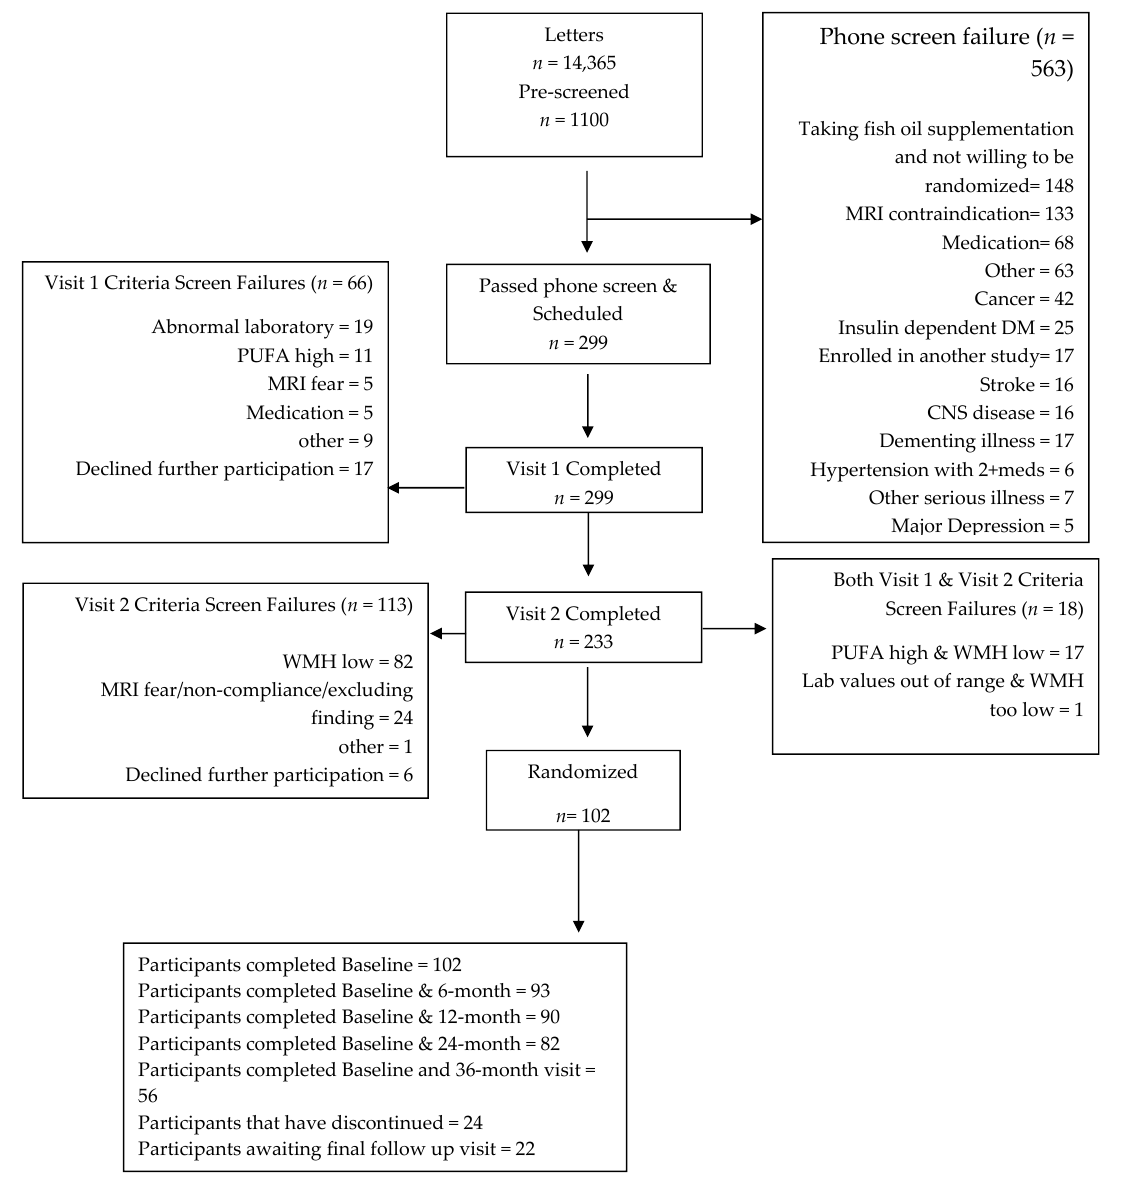
Figure 3. PUFA Trial Participant Flow. Table 2. Baseline Characteristics of the Participants and According to Randomization ( n =